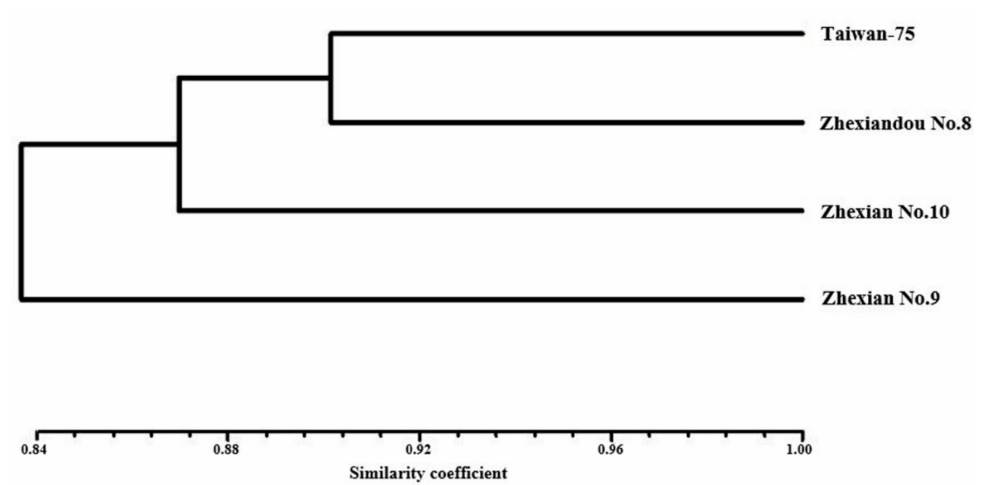
Figure 2. Clustering of the four cultivars based on the UPGMA analysis.